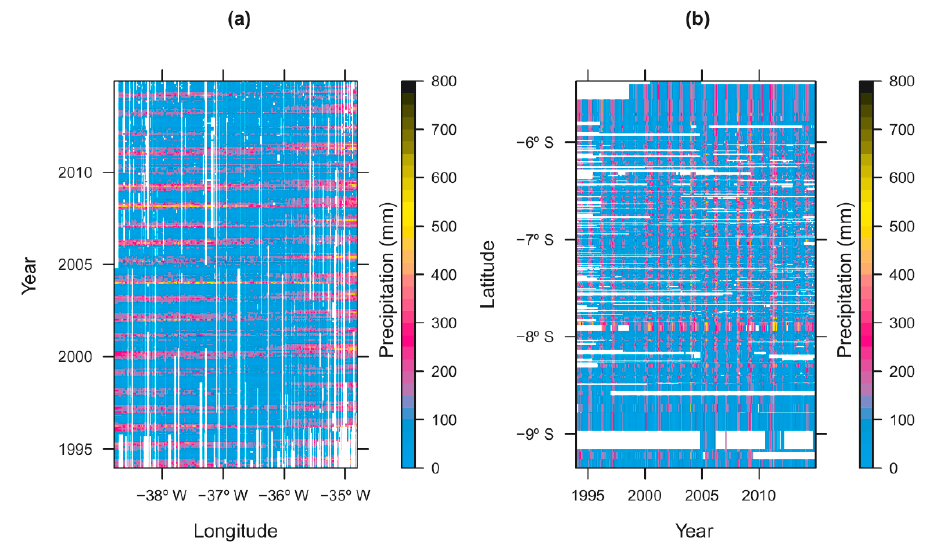
Figure 1. Monthly rainfall of the 269 stations in the period of 1994–2014. Missing data is shown as white tones.